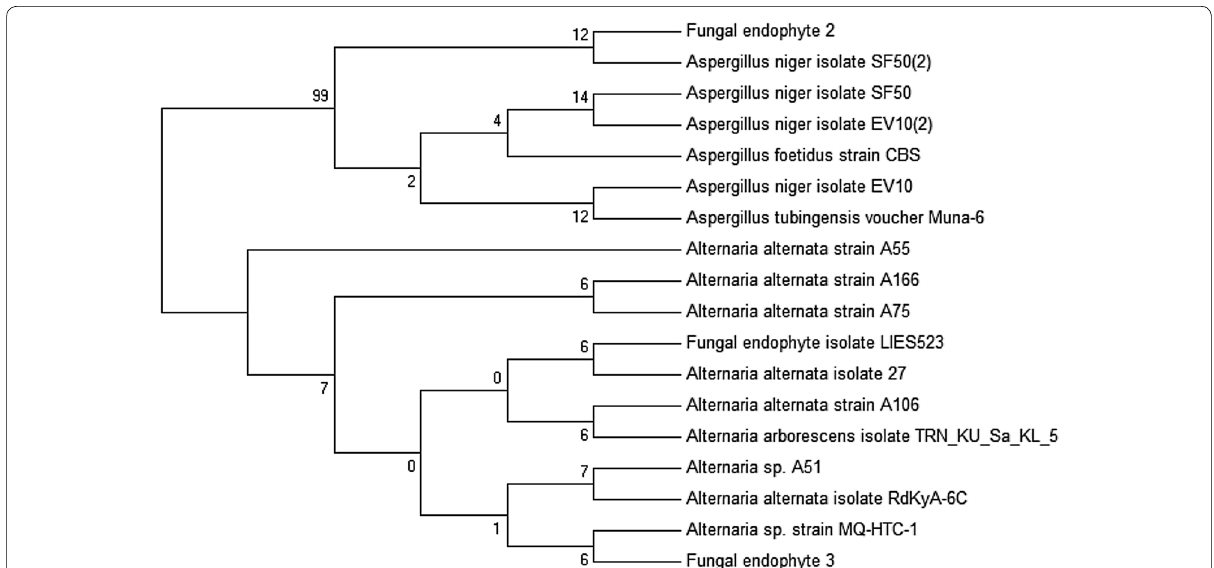
Fig. 2 Molecular phylogenetic analysis of the endophytic fungi of Plumbago zeylanica by maximum likelihood method along with the homologous ITS sequences retrieved from the gene bank